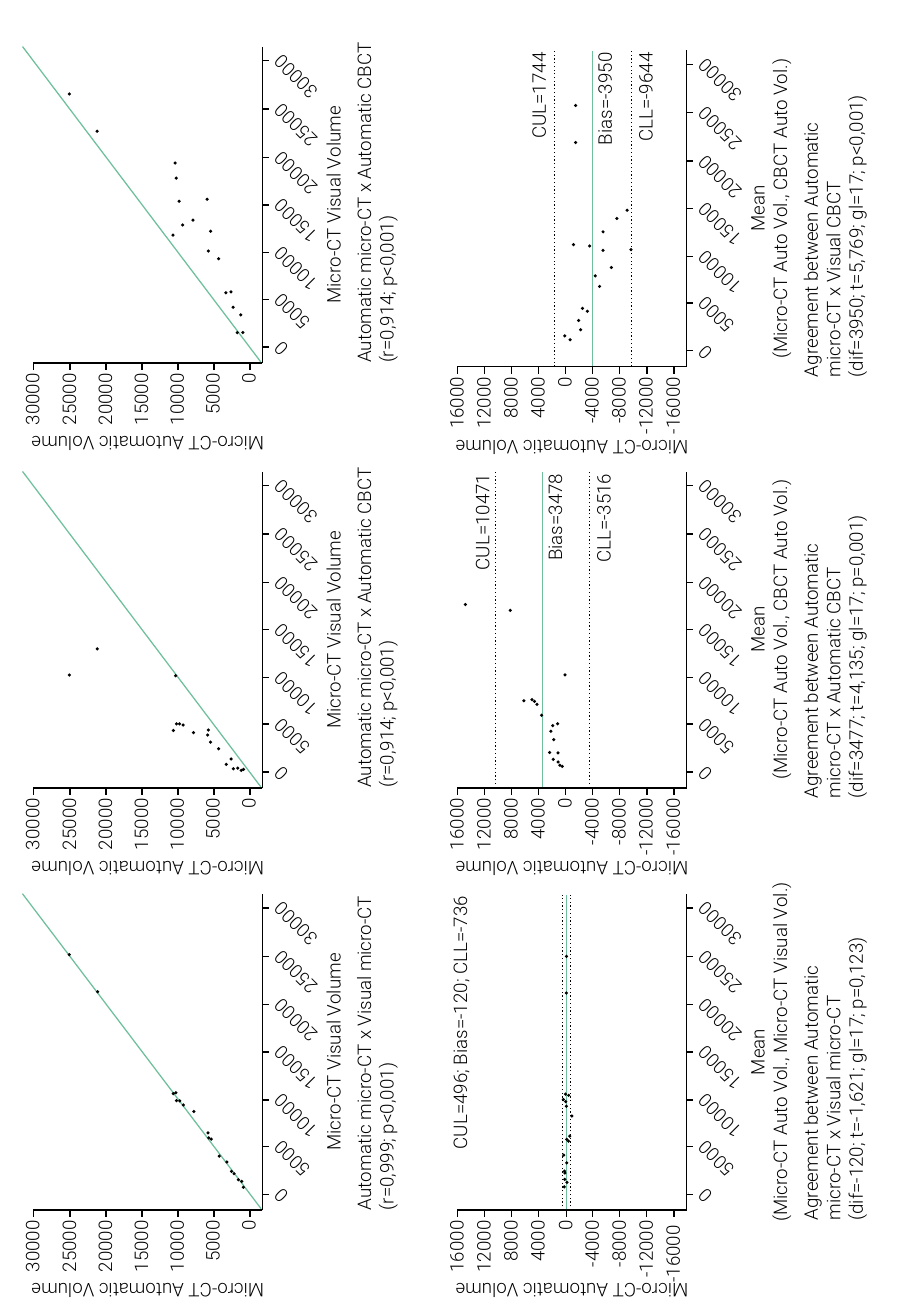
Figure 4. Correlations and agreement between the root canal volumes for the tested acquisitions and thresholds and the gold